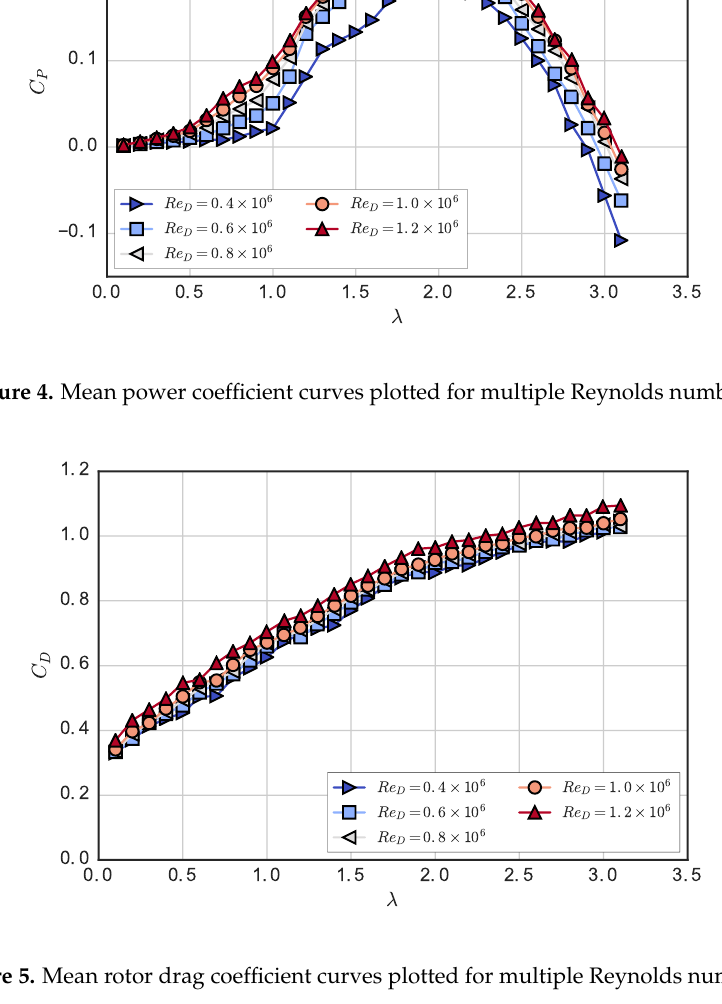
Figure 5. Mean rotor drag coefficient curves plotted for multiple Reynolds numbers. Mean power and drag coefficients at λ = 1.9 are plotted versus the Reynolds number in Figure